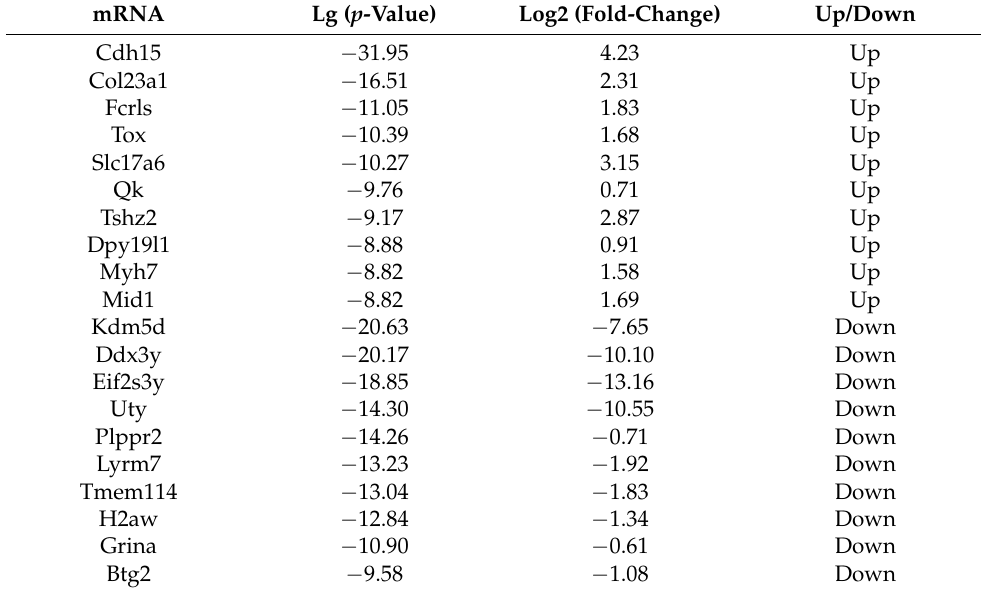
Table 1. The top 20 differently expressed mRNAs based on p